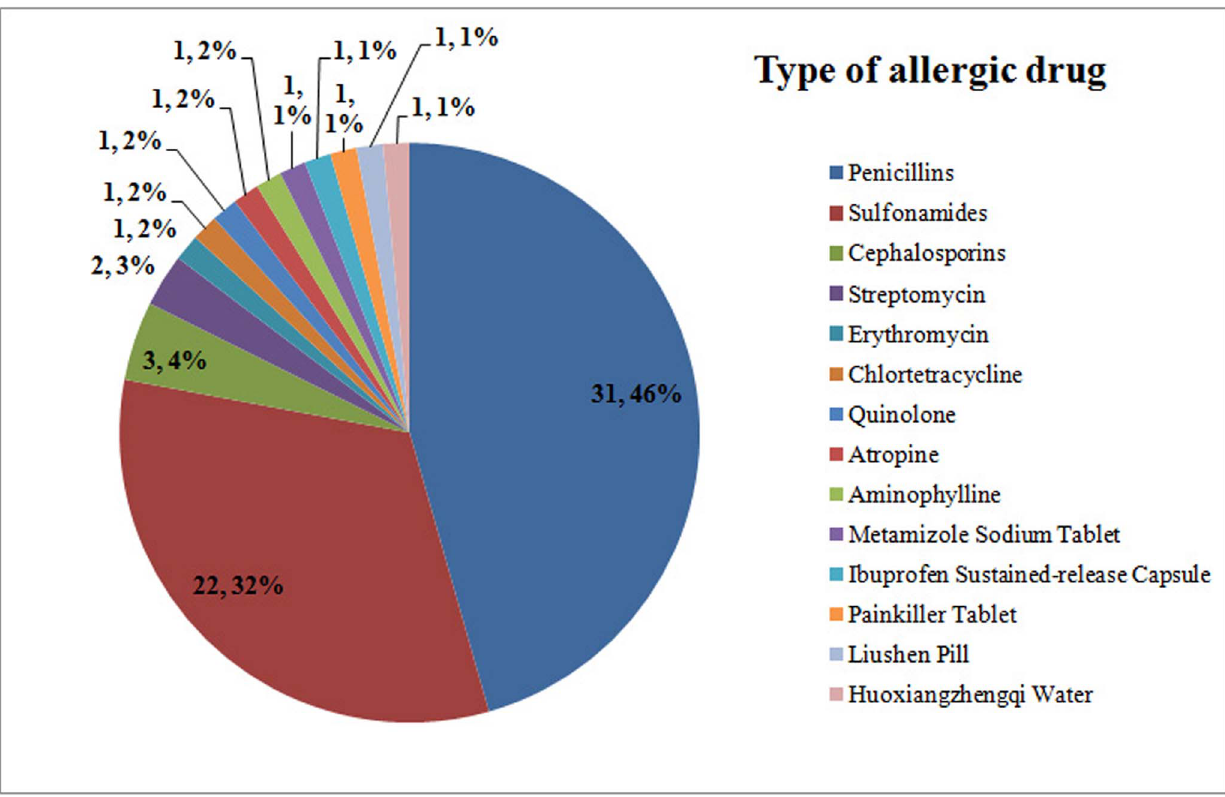
Figure 2. Fifty-eight patients had drug allergy, including 50 patients having allergic reactions to one kind of drug, six patients to two kinds of drugs and two patients to three kinds of drugs. The two numbers indicate the number and percentage of patients.